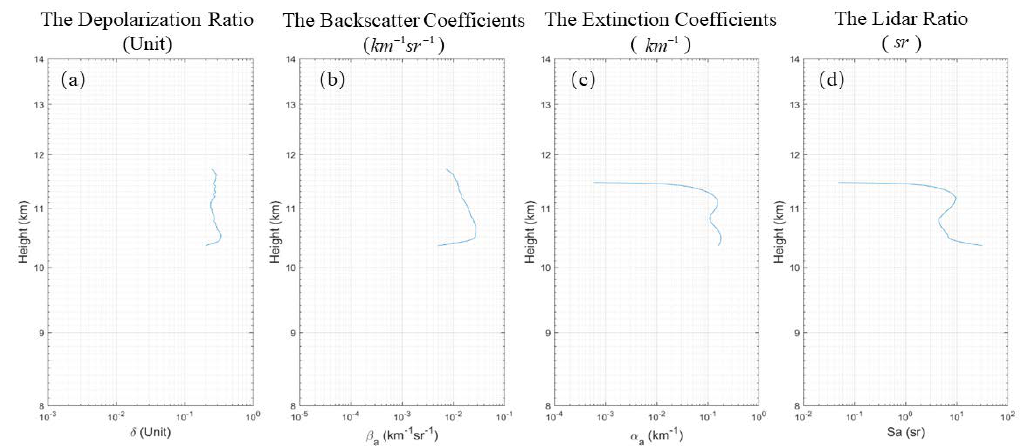
Fig.4. Retrieval profiles of cirrus clouds at an altitude of 10-12km around 18:35pm, 15 April 2019. These four pictures are: (a) the depolarization ratio; (b) the backscatter coefficients; (c) the extinction coefficients; (d) the extinction-to-backscatter